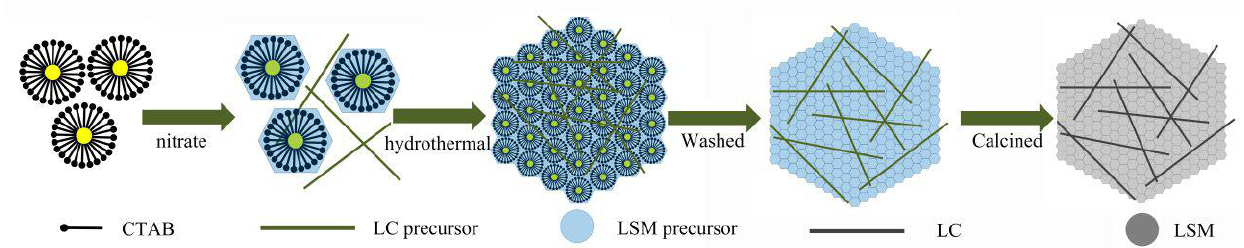
Figure 1. Synthesis of the LC-LSM hybrid catalyst. Copyright 2018 by the American Chemical Society [36].